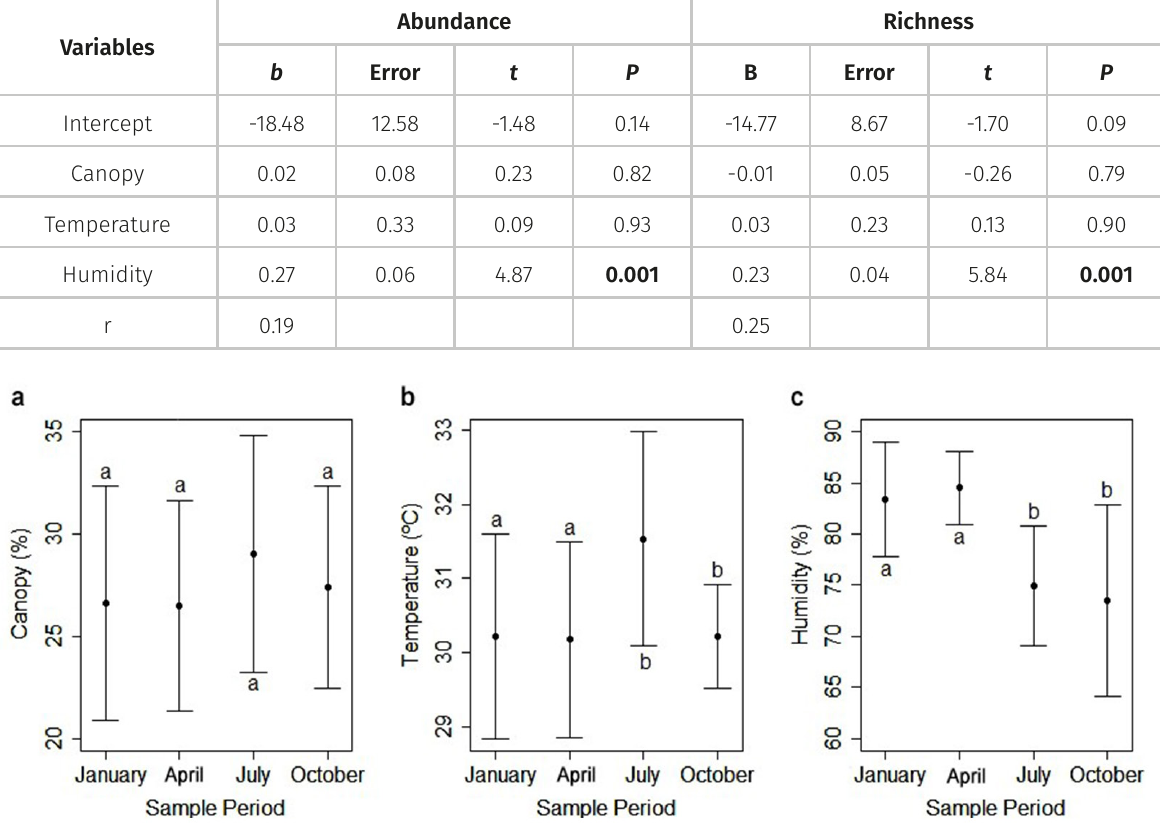
Figure 3. Comparisons of canopy opening (a), temperature (b) and air humidity (c) near the Silvio Braga HPP, in Western Pará between sample periods. Letters on the standard deviation bars indicate significant differences between